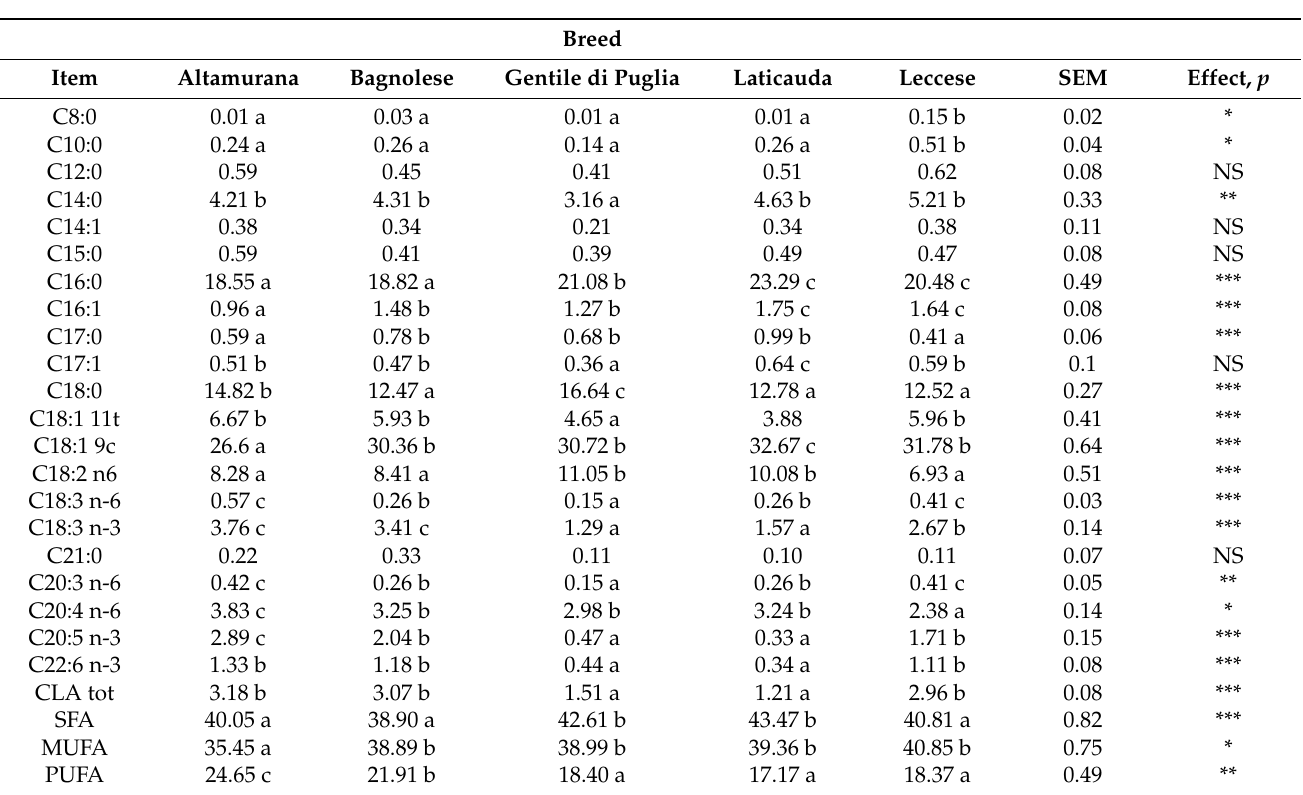
Table 3. Intramuscular fatty acids content (g/100 g fatty acid methyl esters) of Longissimus lumborum (LL) muscle of lambs from five sheep breeds reared in continental Southern Italy (means ± SEM).